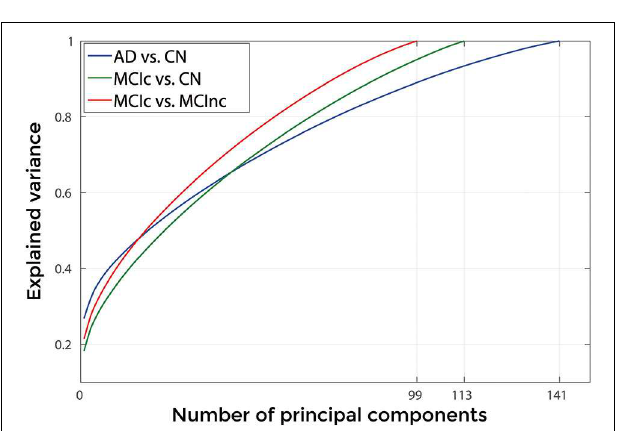
FIGURE 4 | Explained Variance as a function of the number of considered principal components sorted in accordance to their FDR, when using GM tissue probability map and no smoothing, for the following comparisons: AD vs. CN, MCIc vs. CN, MCIc vs. MCInc.